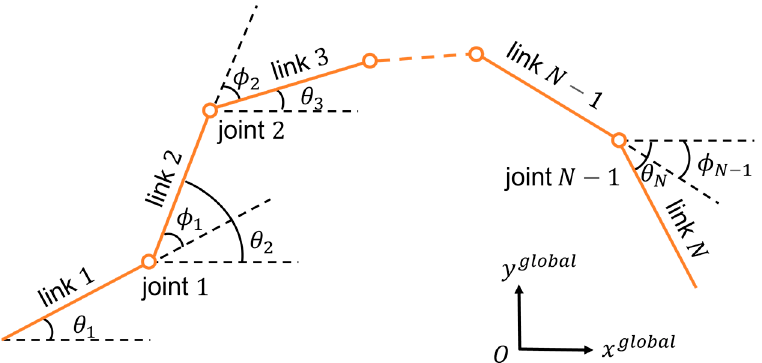
Figure 2. Simple structure of snake robot with 𝑁 − 1 yaw joints.